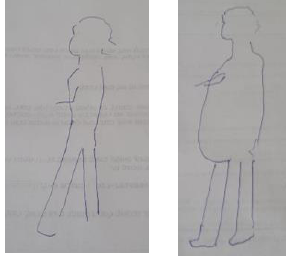
Figure 2. Self-figure drawing drawn by 75-year-old female undergoing hemodialysis or peritoneal dialysis: pre-diagnosis vs. at present.